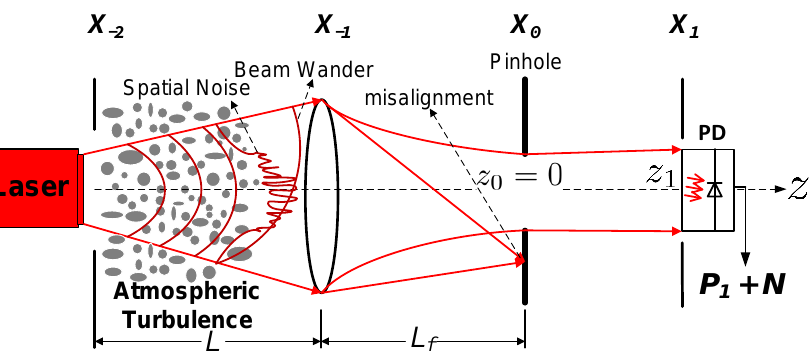
Figure 9. Spatial filtering using pinhole installed before the PD.